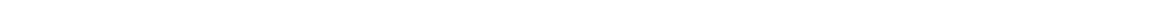
Fig. 4 Correlation of genomic mutations and protein expressions. a Differentially mutated genes and their pathways in PX1 – 3, * P < 0.05, ** P < 0.01 (Fisher ’ s exact test). b Protein expression status of selected mutated genes. c Differential protein expression of mutated genes in the major cancer driver pathways. The left panel summarizes the correlation of altered protein expression and gene mutations of selected proteins in major oncogenic and tumor suppressive pathways; numbers in parenthesis represent number of patients that differential protein expression were detected, number of mutations detected, and number of cases where both were detected, respectively. Right panel shows differential protein expression and gene mutations in each patient. Large dots depict changes in protein expression, and small dots depict a variety of gene mutations. d Altered expression of tumor proteins associated with CDH1 mutations. Boxplots show protein expression levels of CDH1 -mutated and CDH1- wild-type patients (* P < 0.05; ** P < 0.01; *** P < 0.001, Wilcoxon rank-sum test). Whiskers show the 1.5-fold